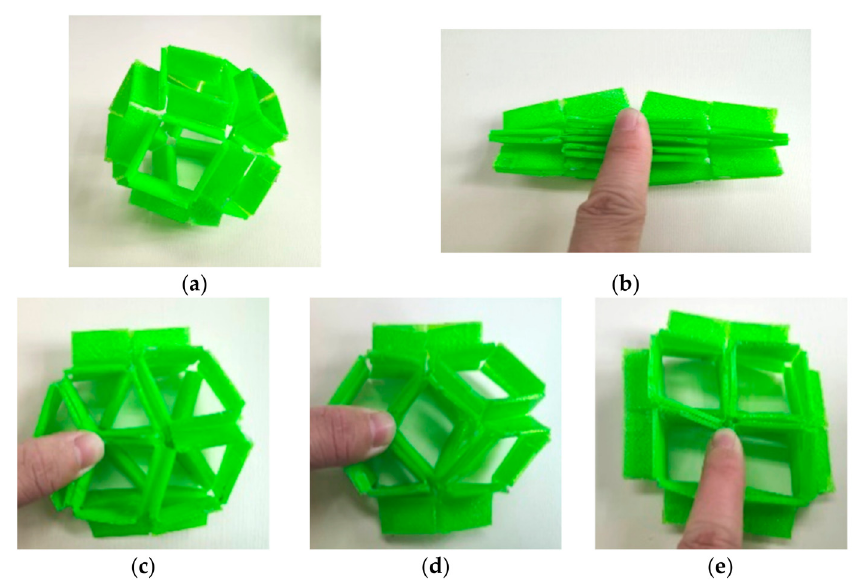
Figure 7. Shape-shifting patterns of 3D printed origami flexiball metamaterial: ( a ) freely expanded pattern; ( b ) fully compressed pattern; ( c ) fully compressed pattern at symmetric points; ( d ) fully compressed pattern at symmetric faces; ( e ) fully compressed pattern at symmetric